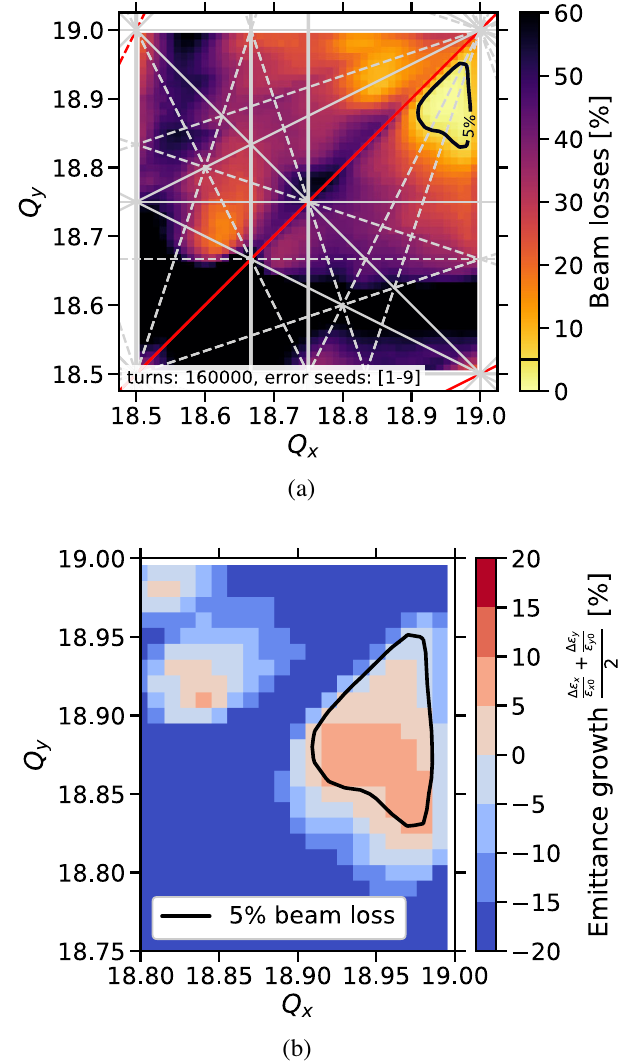
FIG. 7. FFSC results for full field error model as a function of the transverse tunes. (a) Beam losses. (b) Transverse emittance